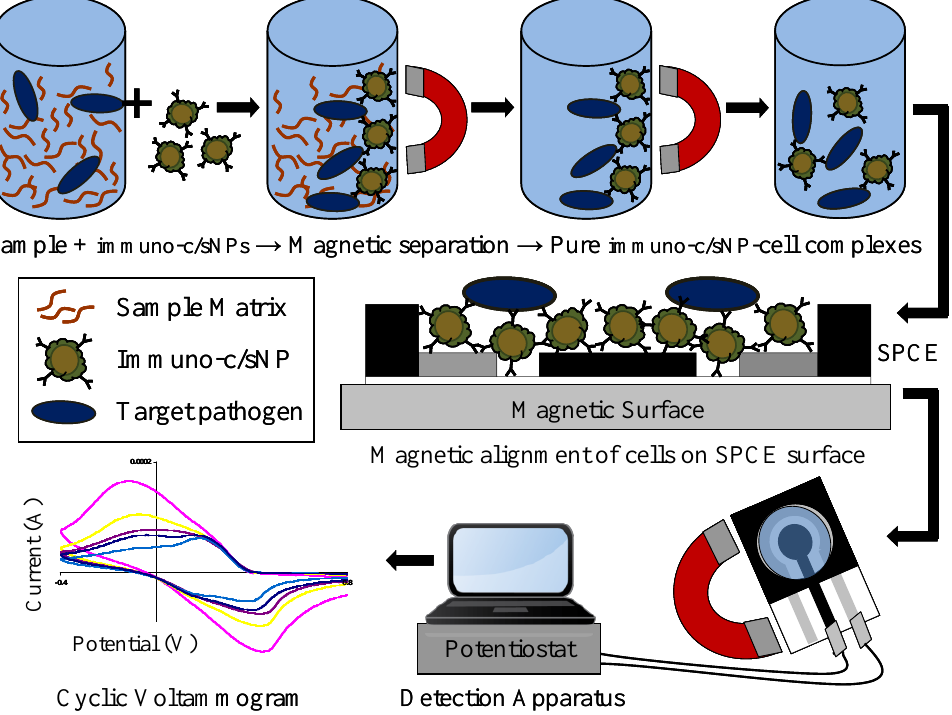
Figure 2. Immunomagnetic separation from sample matrix, magnetic alignment on SPCE surface, and electrochemical detection of B. cereus and E. coli O157:H7